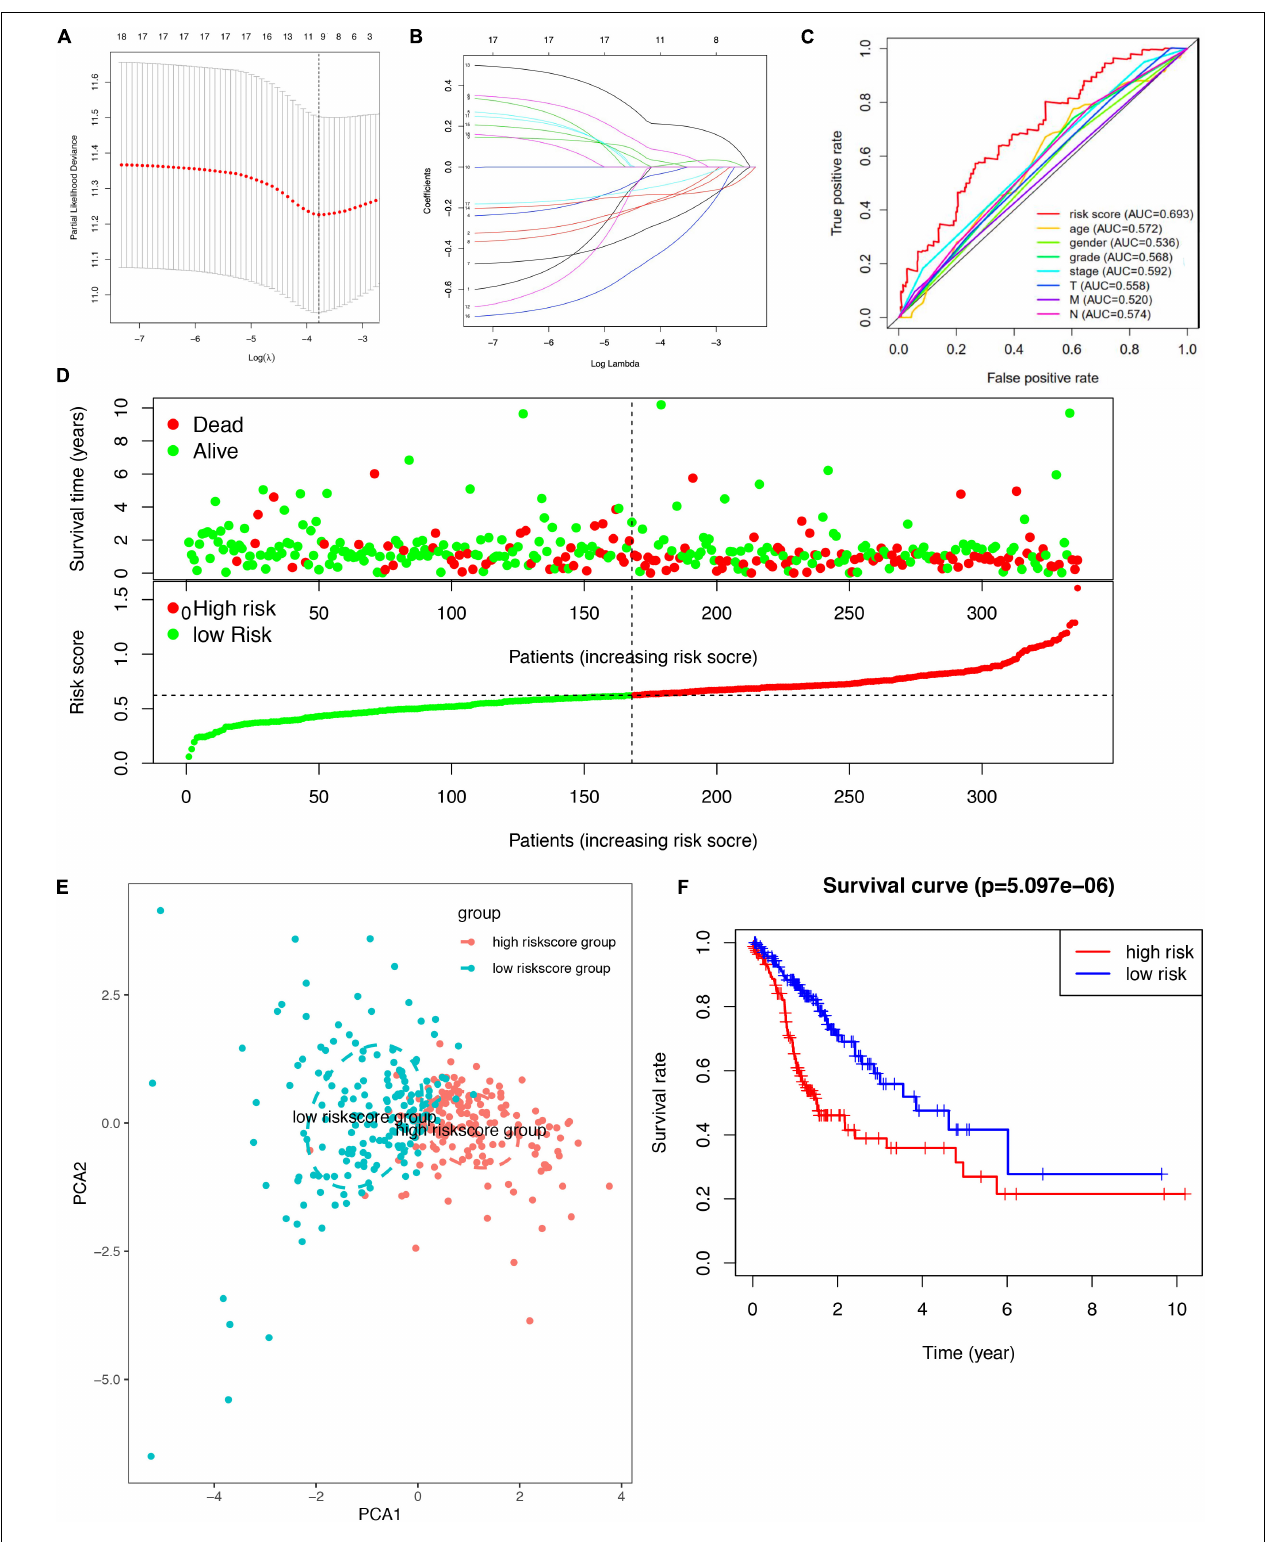
FIGURE 4 | Lasso regression identified the prognostic model in STAD. (A,B) Lasso regression complexity was controlled by lambda using the glmnet R package. (C) The multi-ROC of risk score and clinical features. (D) Risk plot between the high- and low-risk score groups. (E) Principal component analysis for the risk scores. (F) Overall survival analysis between high and low-risk score